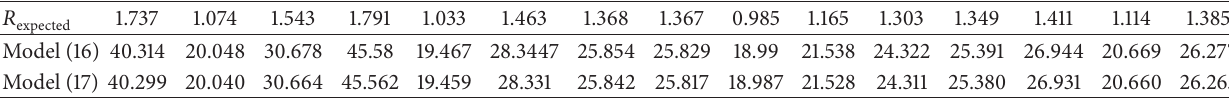
Table 1: Solution of models (16) and (17) for a number of the fixed mean levels. 𝑅 expected